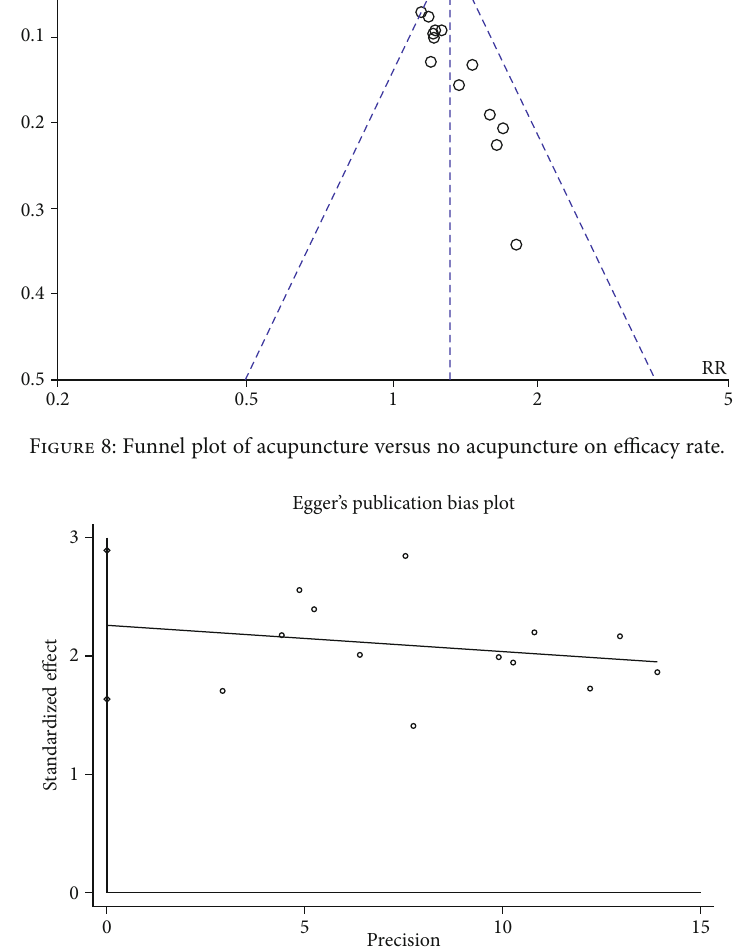
Figure 9: Egger ’ s publication bias plot of the e ffi cacy